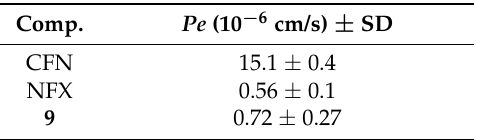
Table 6. PAMPA results for compound 9 and the references: well-permeable caffeine (CFN) and low-permeable norfloxacin (NFX). Comp.